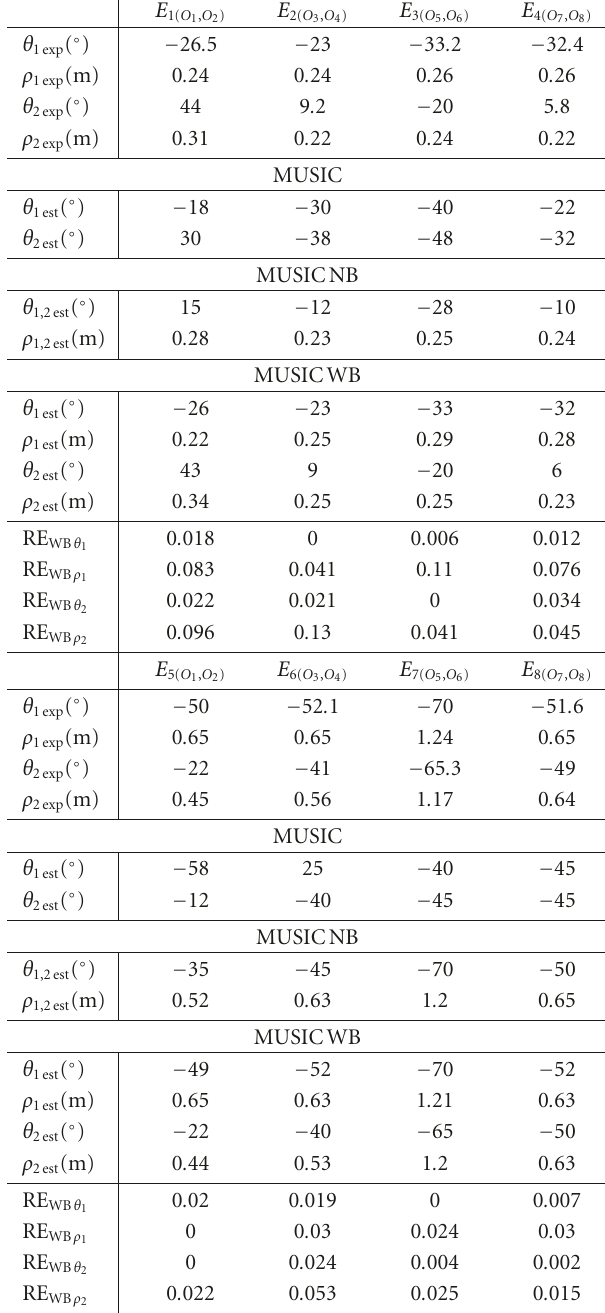
Table 2: The expected (exp) and estimated (est) values of range and bearing objects (negative bearing is clockwise from the